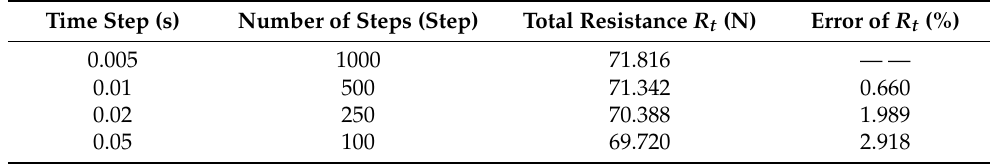
Table 4. Time step convergence analysis for steady